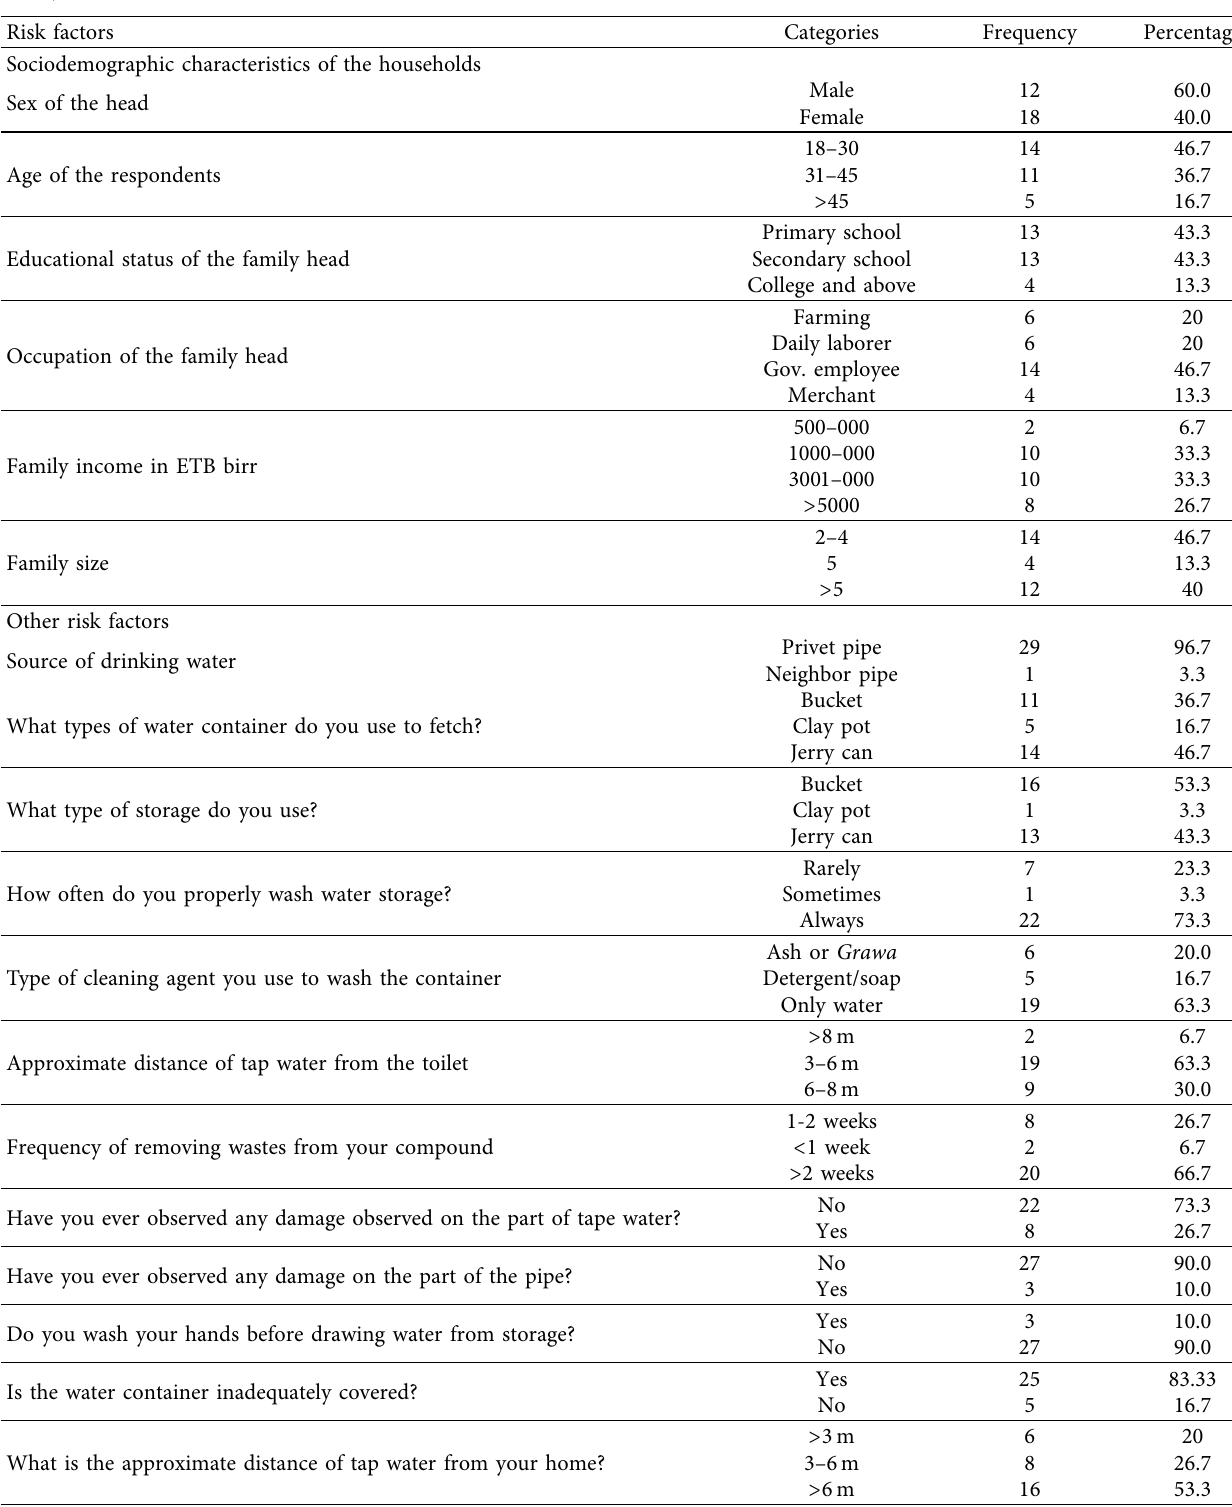
Table 3: Sociodemographic characteristics of the participant and some other risk factors for drinking water pollution in Addis Kidame Town,